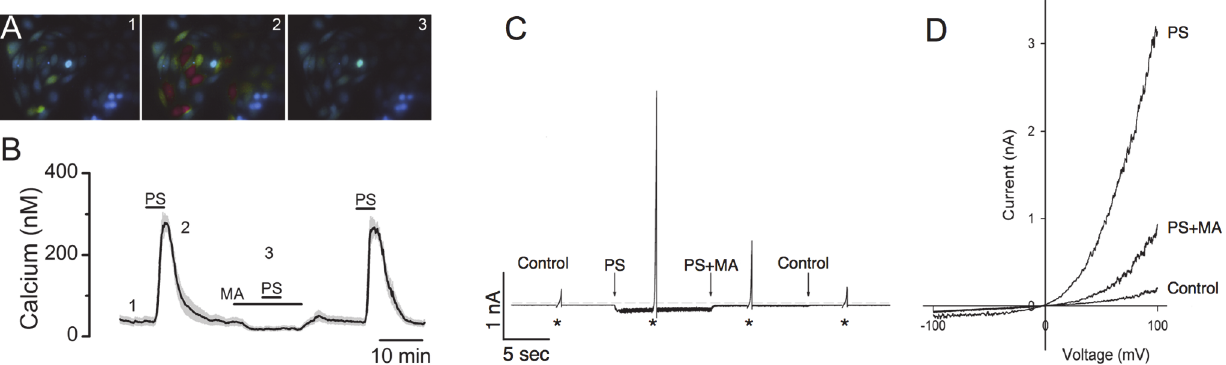
Fig 2. Expression of recombinant mouse retinal TRPM3. A, B ) Ca 2+ signals were recorded from CHO-K1 cells transiently transfected with mouse TRPM3 by Fura-2-based ratiometric imaging (n = 8 PS-responsive CHO cells). Signal from control solution (1) and Pregnenolone Sulfate (PS)-activated rises in calcium (2). The PS signal was abolished by pretreatment with mefenamic acid (MA; 3). In ( B ), black line is average, grey is SEM. C, D) CHO-K1 cells were transiently transfected with mouse mCherry-tagged TRPM3. PS activates an outwardly rectifying current in mCherry — TRPM3 transfected cells identified with mCherry fluorescence. PS-stimulated currents were measured from 11 cells; inward currents at -100 mV were 83 ± 13 pA (SEM) and outward currents were 2175 ± 128 pA at +100 mV. Non-transfected CHO cells show no measurable response to application of PS. The currents were blocked by MA. * in ( C ) indicate time when the holding potential was ramped from -100 to +100 mV to determine I – V relationship in ( D